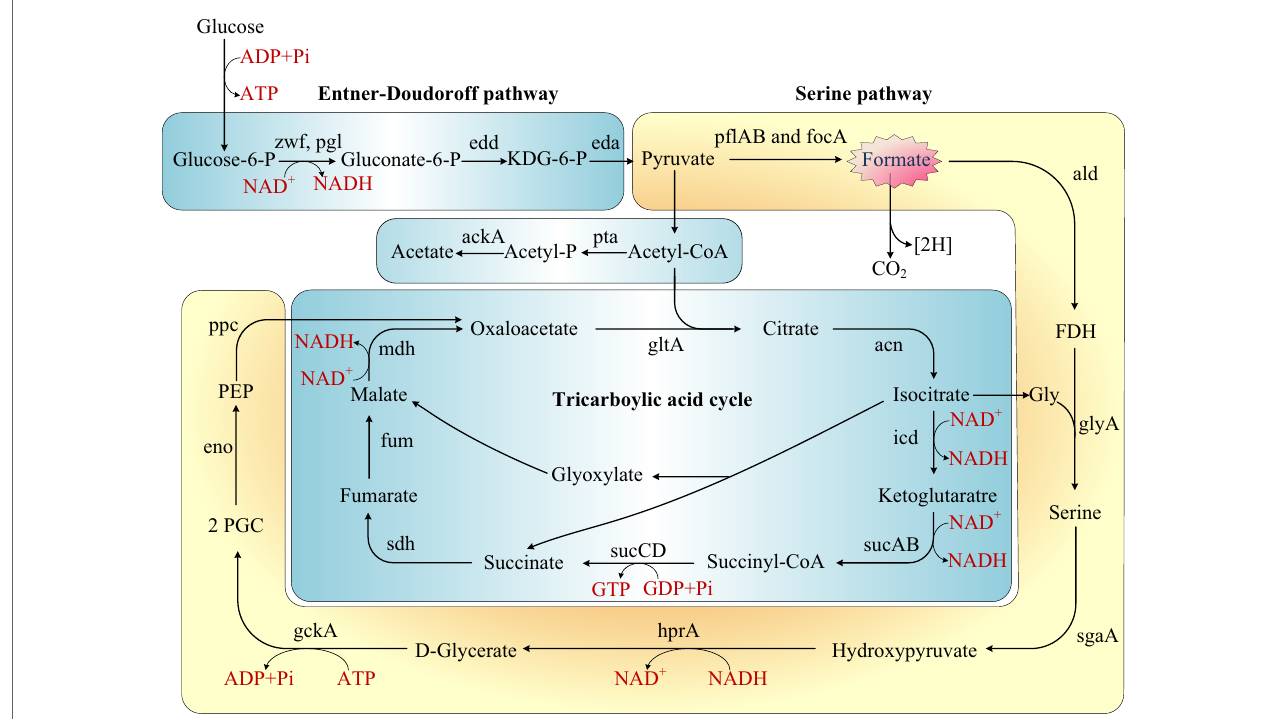
FigUre 4 | rewiring of transcriptional regulatory networks in the carbohydrate mechanisms of Shewanella which colonized in the sewage according to Kegg and previous research (scott and nealson, 1994; Fredrickson et al., 2008; Pinchuk et al., 2011) . Genes that encode the enzymes